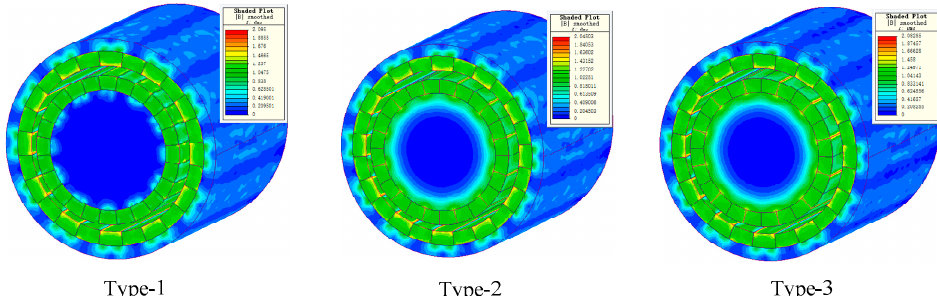
Figure 8. 3D-FEA models of three types of HPMCs with 2 mm axial displacement.